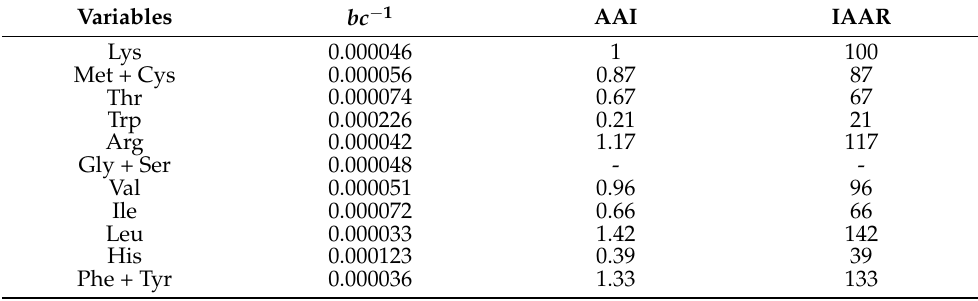
Table 8. Amino acid utilization efficiency ( bc − 1 ), optimal amino acid intake (AAI) and optimal amino acid ratio (IAAR) for Japanese quail breeders in a nitrogen balance